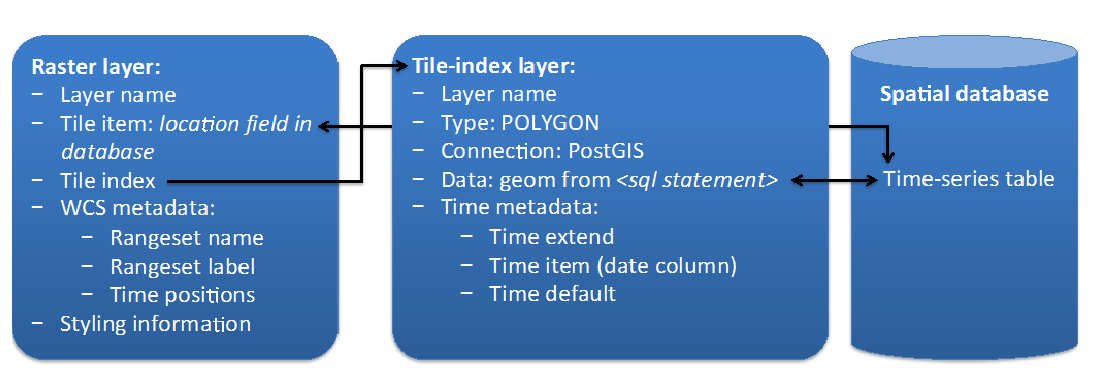
Figure 6. MapServer configuration for tile-index and raster layer.